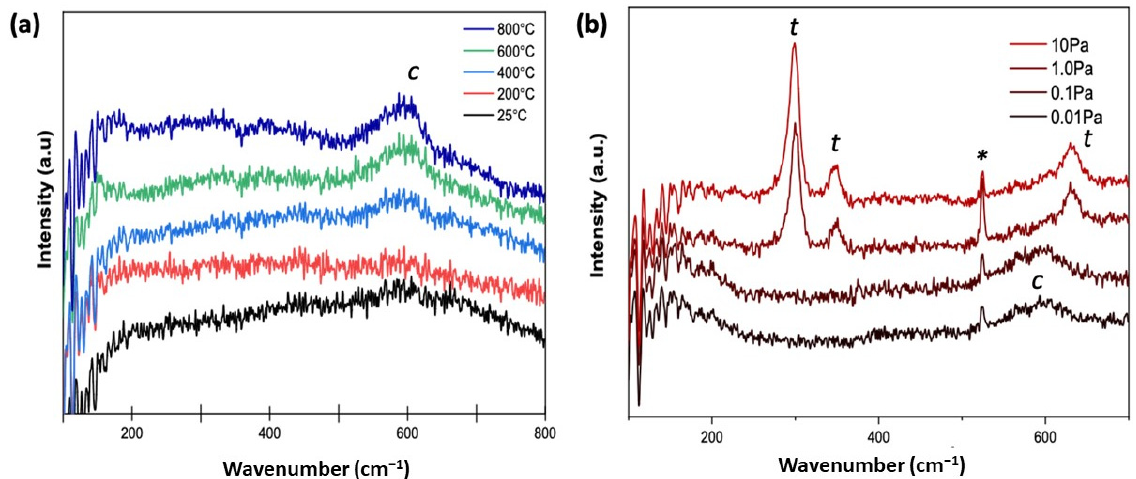
Figure 2. Raman spectra of ( a ) as-deposited ScYSZ thin films on PtTi-SiO 2 -Si substrate with varying substrate deposition temperatures, T s = 25 ◦ C, 200 ◦ C, 400 ◦ C, 600 ◦ C, and 800 ◦ C, with constant P O = 0.1 Pa; and ( b ) with various oxygen partial pressures, P O = 0.1 Pa 10 Pa, at T s = 600 ◦ C. (* SiO 2 substrate).